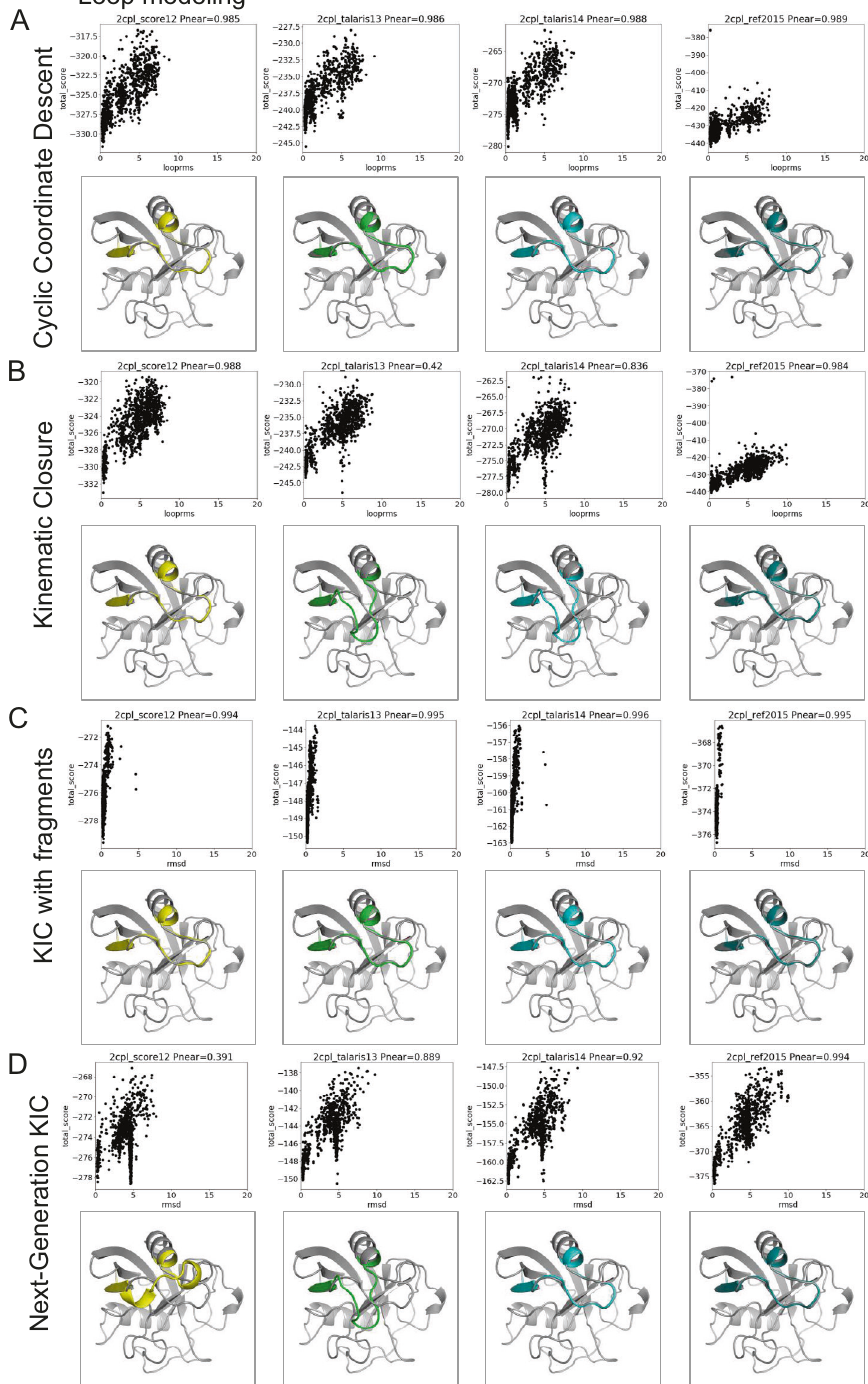
Fig. 4 Score function comparison for one protein and different loop modeling protocols. The protocols are A cyclic coordinate descent — CCD, B kinematic closure — KIC, C KIC with fragments, and D next-generation KIC — NGK. Score functions are sorted from oldest to newest (left to right) and the models are colored in gray as the native (PDB) structure, then according to the score functions in order: yellow — score12, green — talaris13, cyan — talaris14, and teal — ref2015. This fi gure shows a particularly interesting example, which is not necessarily representative of other targets. Interesting for this target are the differences in the energy landscapes that are sampled and the presence of a second, incorrect conformation with low energy for some protocols and some score functions, but not others. For 3 out of 7 targets in our comparison, including this one, most conformations that KIC (kinematic closure) with fragments samples, are close to the native structure. Again, for larger benchmarks, this is likely not as often the